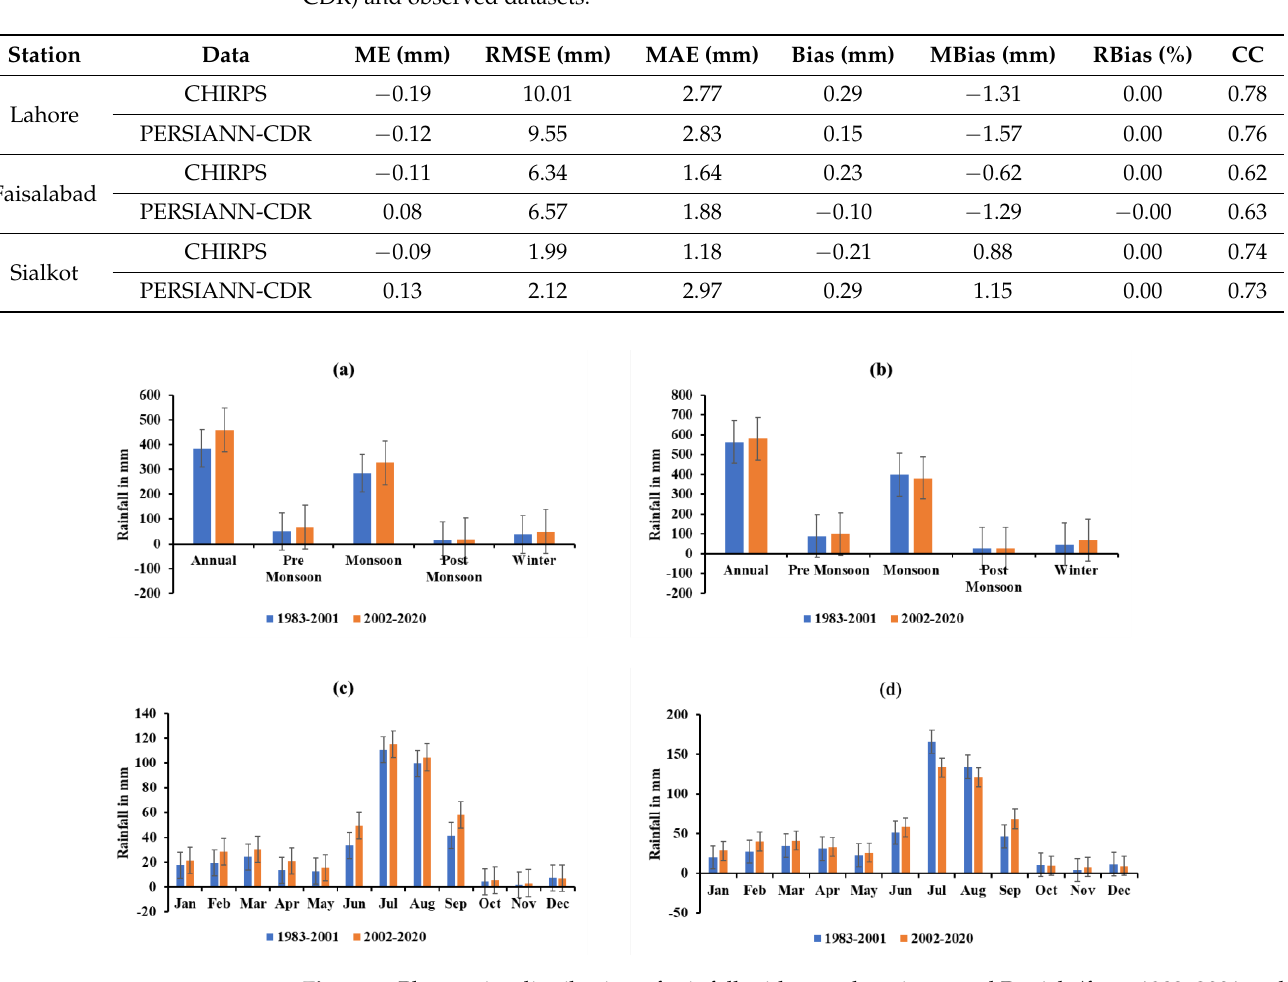
Figure 3. Phase-wise distribution of rainfall with error bars in central Punjab (from 1983 – 2001 and 2002 – 2020). ( a ) Mean annual and seasonal rainfall of CHIRPS; ( b ) mean annual and seasonal rainfall of PERSIAN-CDR; ( c ) mean monthly rainfall of CHIRPS; ( d ) mean monthly rainfall of PERSIANN-CDR. Out of the two phases, maximum rainfall is observed in Phase-2, whereas dispersal of the PERSIANN-CDR exhibits relatively higher rainfall as compared to the CHIRPS data (Figure 3a–d).